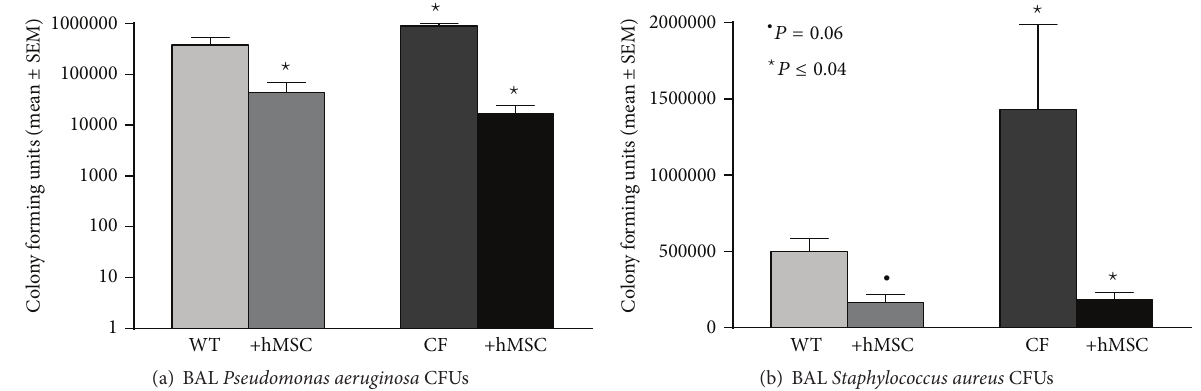
Figure 1: hMSCs in the PA (a) and SA (b) infection model: Cftr tm1Kth (CF) and wild type (WT) controls were infected with 10 5 CFUs of either Pseudomonas aeruginosa or Staphylococcus aureus impregnated into agarose beads to generate chronic gram negative or gram positive chronic infection models in CF. hMSCs were administered on day 1, 24 hours after infection. Mice were followed up to 10 days and were then euthanized for bacteria burden (BAL CFUs+ whole lung homogenate CFUs, 𝑛 = 4 experiments with 10 animals in each group). hMSCs decreased bacteria burden ( 𝑃 ≤ 0.05 ) in response to both pathogens.